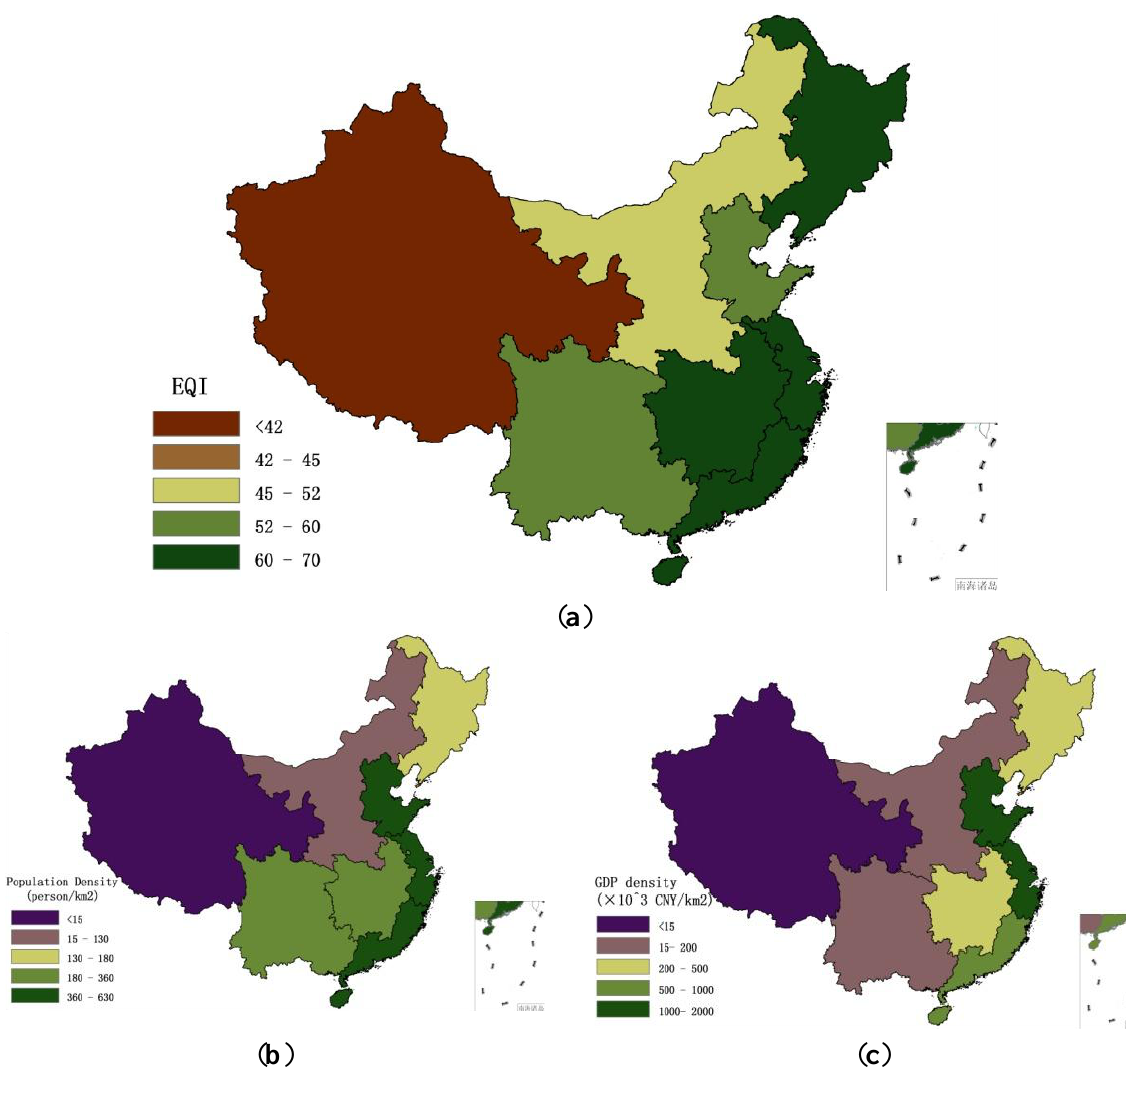
Figure 11. EQI, population density and GDP density in eight economic regions in